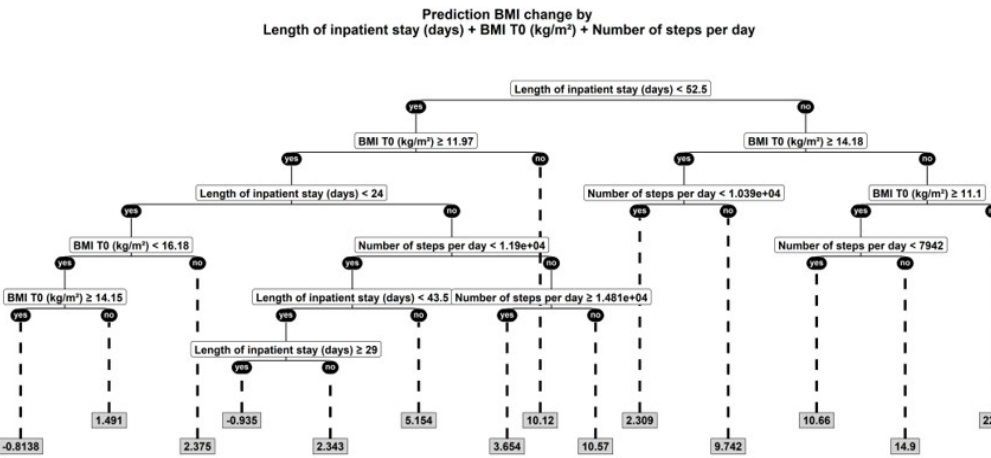
Figure 2. Regression tree for non-linear modelling to test the relation between BMI percent change and further parameters. BMI, Body Mass Index.